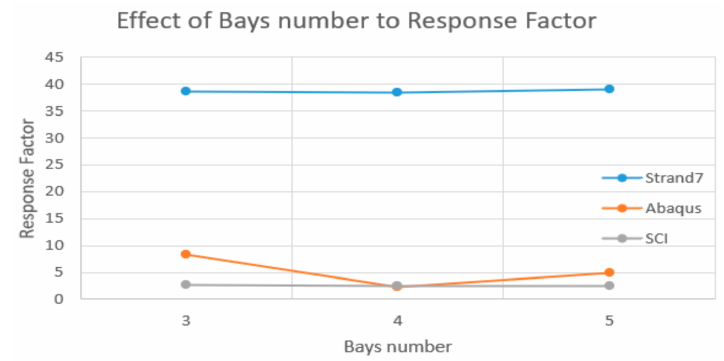
Figure 17. Comparison of Response Factor between Different Bays Number.